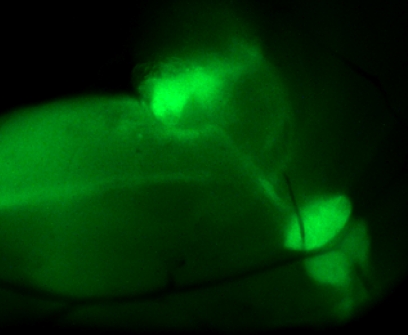
In this whole-mount lateral view of an embryonic day 17.5 mouse brain, an EGFP knock-in allele into the Hoxa2 locus allows direct visualization of pontine neurons during their migration to their final destination in the anteroventral brain stem.